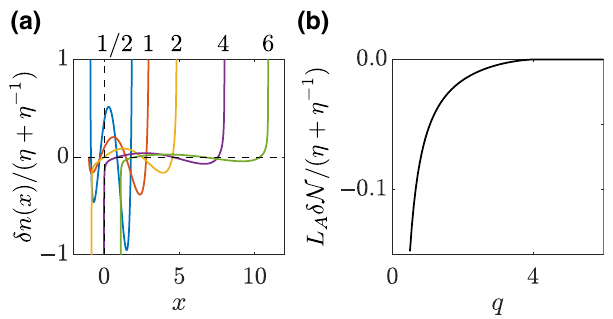
FIG. 6. (a) Correction to the entanglement negativity spec- trum: δ n ( x )/(η + η − 1 ) for a few different values of q as indi- cated on the top of the figure. (b) Correction to the negativity: L A δ N /(η + η − 1 ) as a function of q = L B / L A . √ δ n ( x ) is supported on [ a = q ± 2 q , − , a + ] with a ±